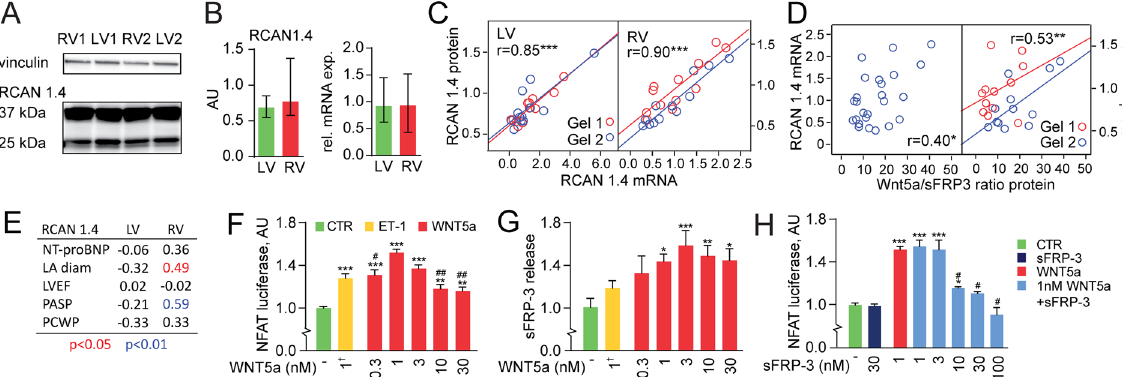
Figure 4. Wnt5a and sFRP3 effects on NFAT signaling. ( A ) Representative immunoblots of RCAN1.4 and loading control Vinculin in the LV and RV of two DCM patients. ( B ) mRNA and protein levels of RCAN1.4 in the LV and RV myocardial tissue of DCM patients (n = 25). ( C ) Correlation between RCAN1.4 mRNA and protein levels (adjusting for gel with partial correlation). ( D ) Correlation between the Wnt5a/sFRP3 ratio and RCAN1.4 mRNA and protein levels (adjusting for gel with partial correlation). ( E ) Correlations between RCAN1.4 and NT-proBNP (n = 25), LA diameter (n = 20), LVEF (n = 23), PASP (n = 24) and PCWP (n = 24) in the LV and RV of DCM patients. ( F ) NFAT luciferase activity in neonatal mouse cardiomyocytes after treatment with endothelin-1 (ET-1) and increasing concentrations of recombinant Wnt5a. ( G ) A relative sFRP3 release in culture medium from F. ( H ) NFAT luciferase activity after treatment with recombinant sFRP3, Wnt5a or both. * p < 0.05, ** p < 0.01, *** p < 0.001 vs. control (CTR), # p < 0.05, ## p < 0.01 vs 1 nM Wnt5a, † 1 µ M endothelin-1 (ET-1). DCM, dilated cardiomyopathy; LA, left atrial; LV, left ventricle, LVEF, left ventricular ejection fraction; NFAT, nuclear factor of activated T-cells; NT-proBNP, N-terminal pro-brain natriuretic peptide; PASP, pulmonary artery systolic pressure; PCWP, pulmonary capillary wedge pressure; RCAN1.4, regulator of calcineurin 1 isoform 4; RV, right ventricle; sFRP3, secreted frizzled-related protein